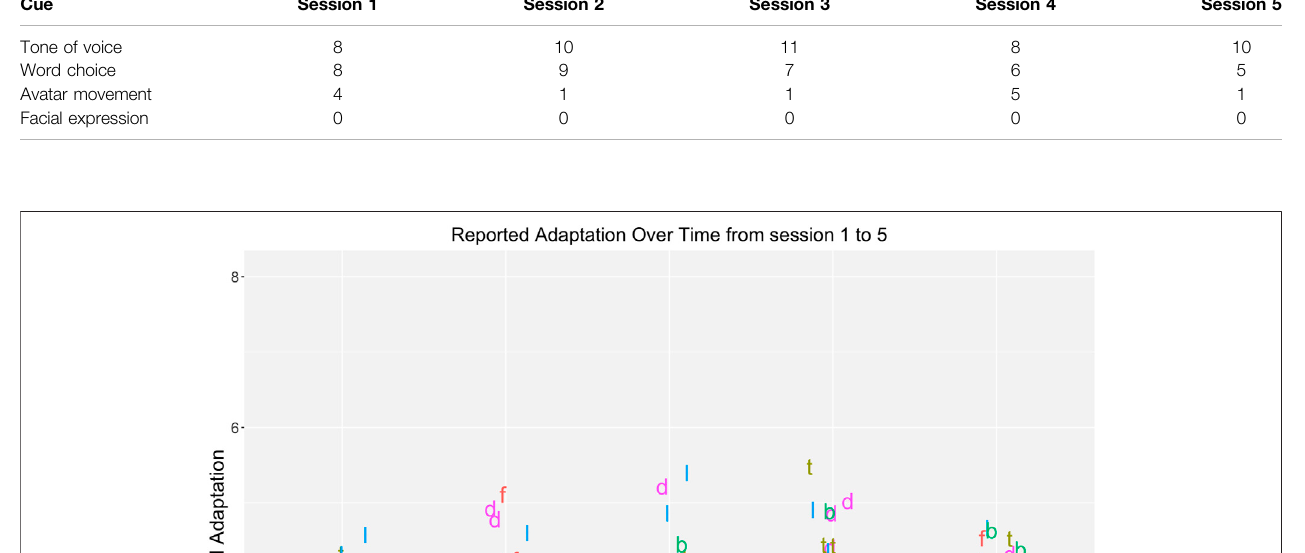
Figure 10 . Marginal and conditional R-squared for the model